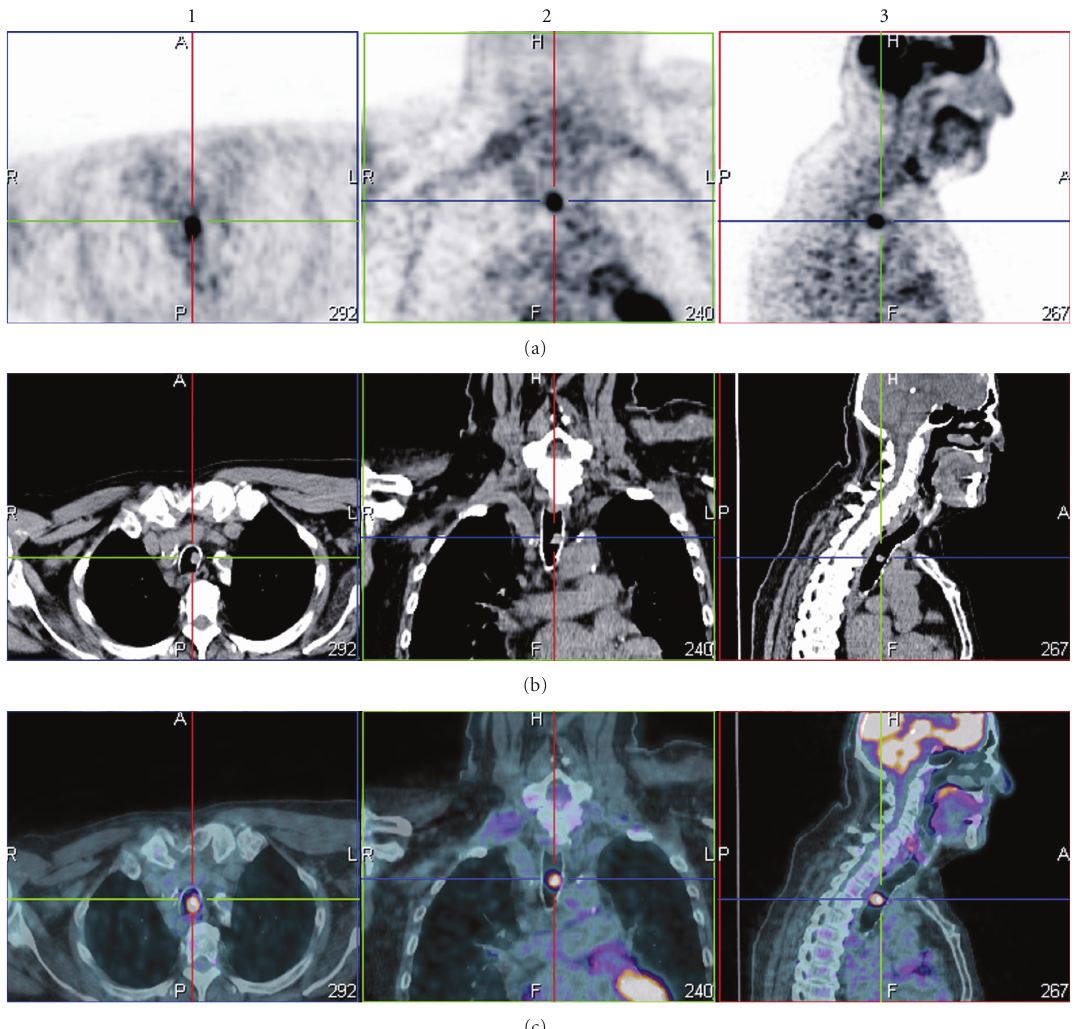
Figure 1: PET scan shows a localized FDG uptake in the middle third of the trachea. (a): PET, (b): CT, (c): PET-CT. (1): axial view, (2): coronal, (3):